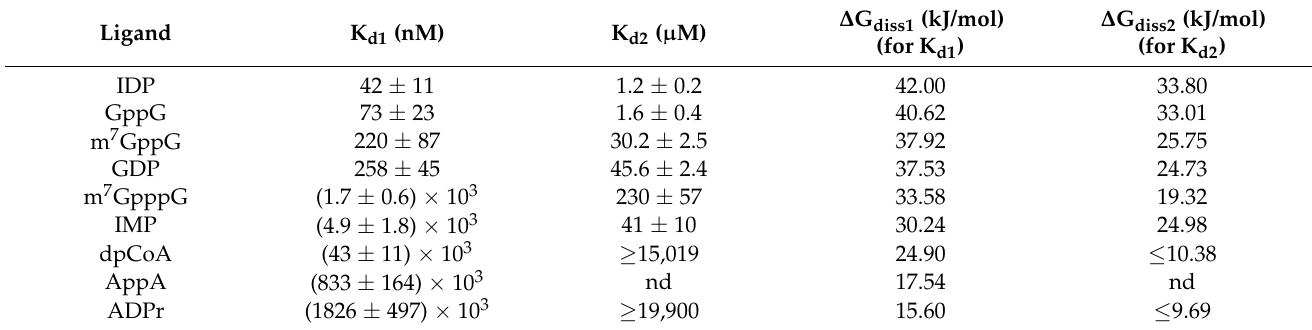
Table 3. K d1 and K d2 binding constants obtained from MST and the free energy associated with dissociation of the complex ( ∆ G diss ) calculated for each binding site (from K d obtained by MST) for tested hNudt16 E76Q-ligand complex samples; nd—not determined.